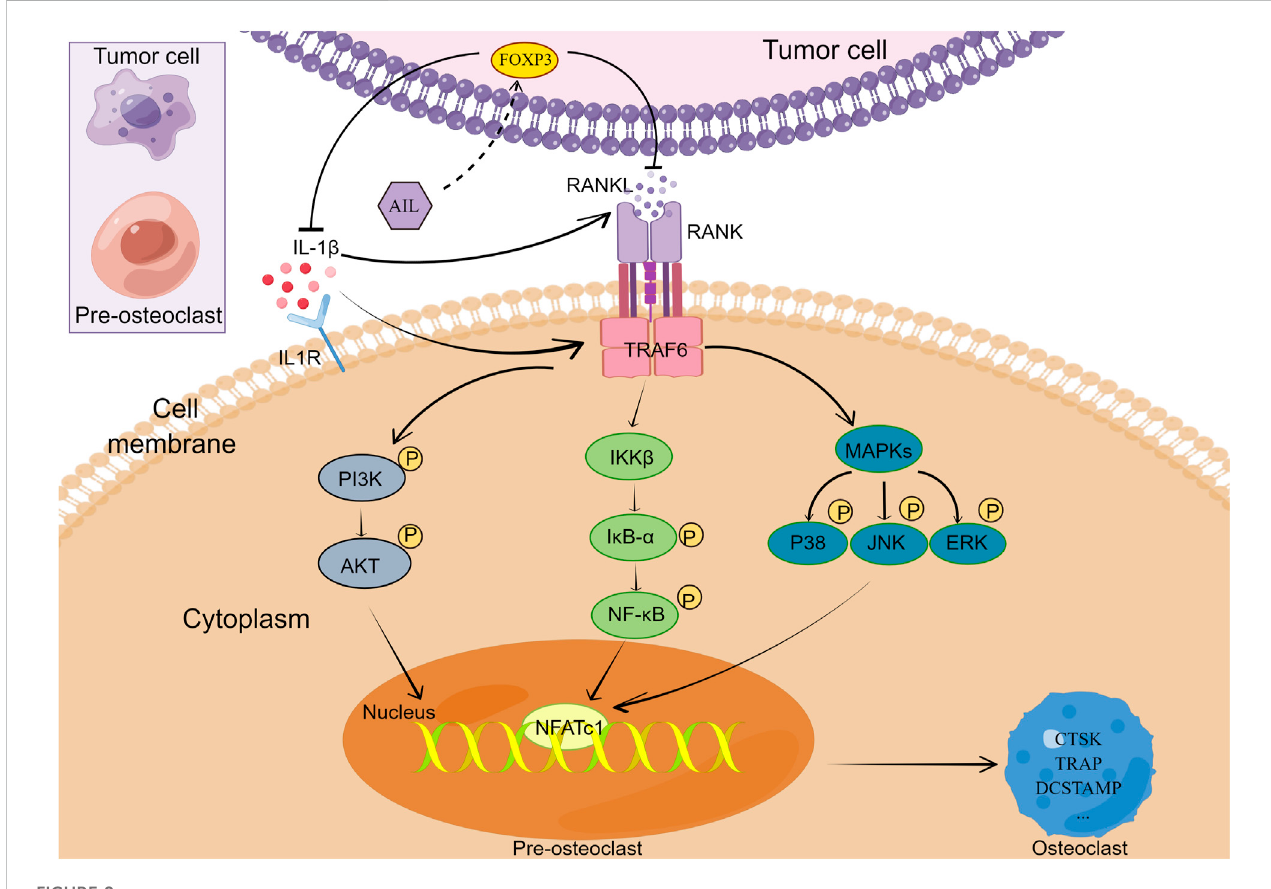
AIL inhibits bone metastasis of breast cancer in multiple